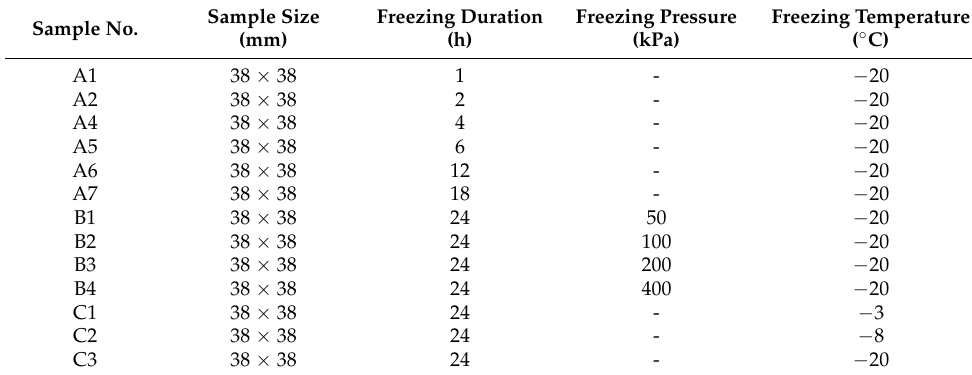
Table 1. Experimental program.